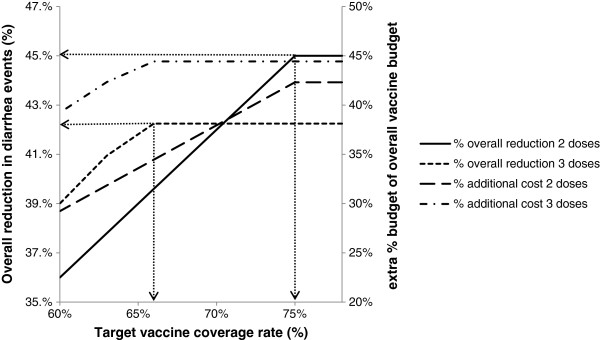
Effect of target vaccine coverage rate on total cost and effect. Total cost (right Y-axis) and effect (reduction in diarrhoea events, left Y-axis) as a function of target vaccine coverage rate. Assumptions: vaccine budget, $200,000; 2-dose vaccine efficacy (strategy A), 60%; 3-dose vaccine efficacy (strategy B), 65%; 2-dose vaccine cost per dose (strategy A), $13.00; 3-dose vaccine cost per dose (strategy B), $10.00; target vaccine coverage, allowed to vary.